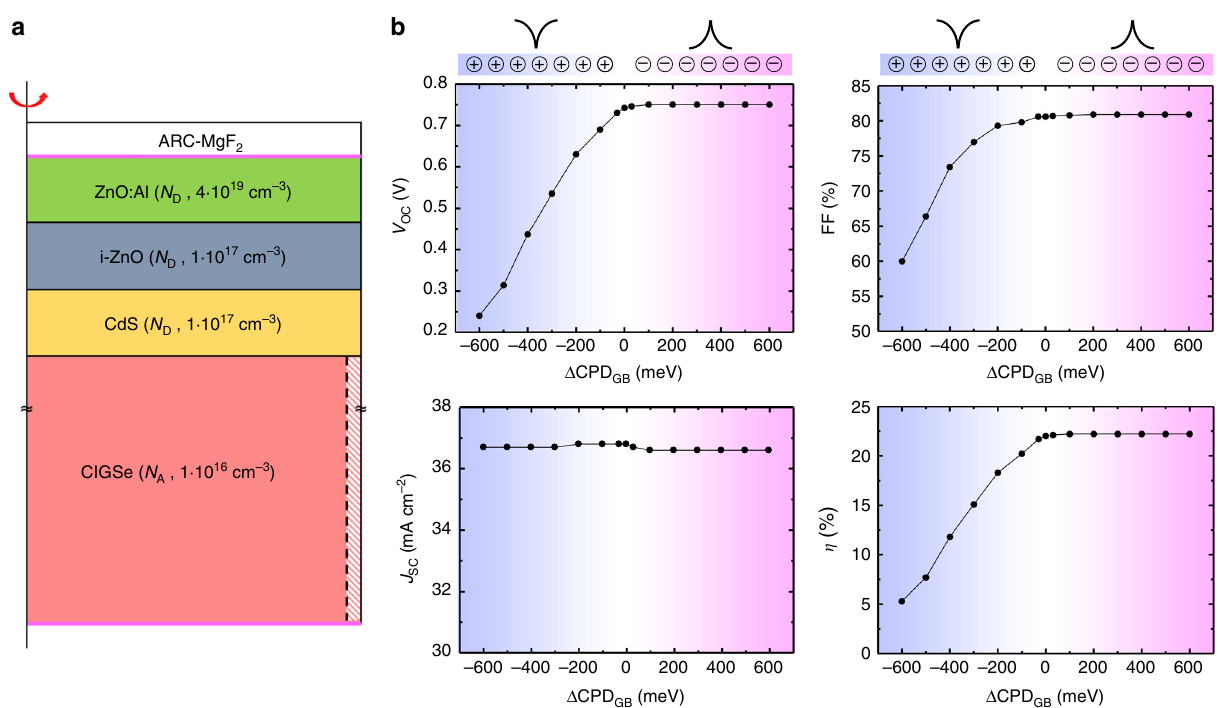
Fig. 4 Numerical simulations of solar cell devices with charged grain boundaries. a Simulated structure and b solar cell fi gures of merit as a function of band bending at the GB. Δ CPD GB < 0 (i.e. positive fi xed charge at the GB) leads to downwards band bending, while Δ CPD GB > 0 (i.e. negative fi xed charge at the GB) leads to upwards band bending. Strong losses in V oc , FF, and η are observed for increasing downward band